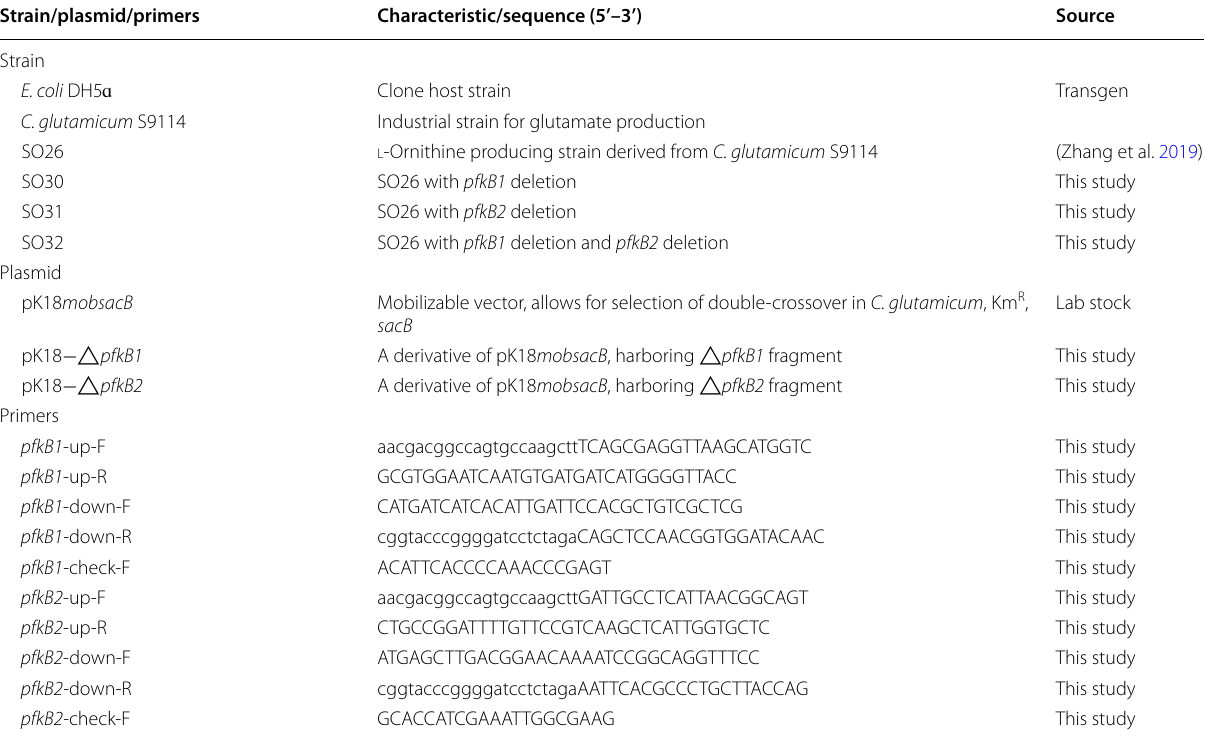
Superscript ‘‘R’’ indicates resistance to the following antibiotics: Km